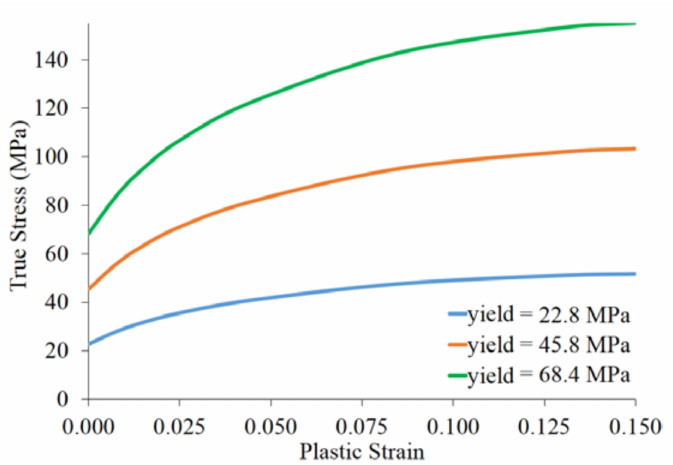
Figure 4. Material properties of lattice